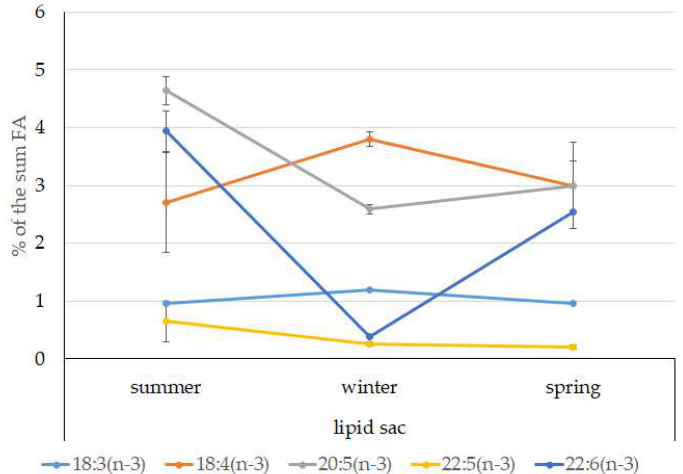
Figure 12. Seasonal dynamic of certain SFA levels (% of the sum of FAs) in the lipid sac in postlarval (L3 developmental stage) daubed shanny from Kongsfjord. The data presented as M ± SE.